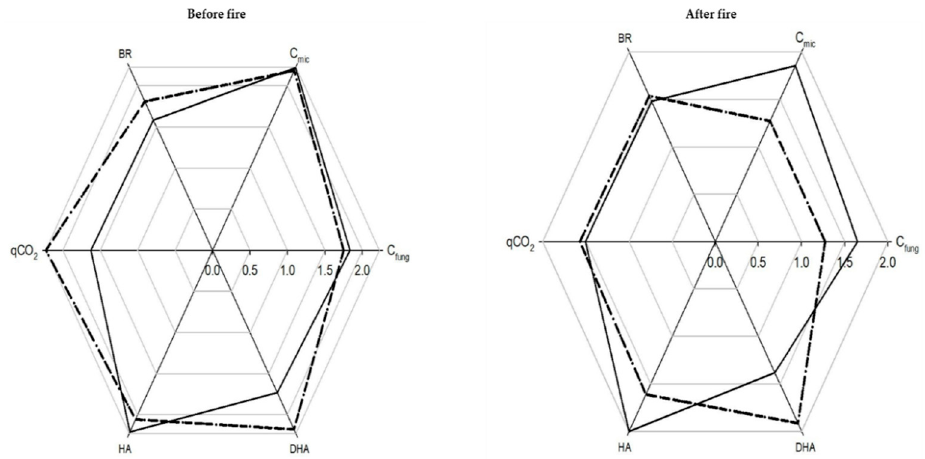
Figure 5. Biological response score star plot of soils collected before and after the fire under pine (dashed line) and herb (black line) species.